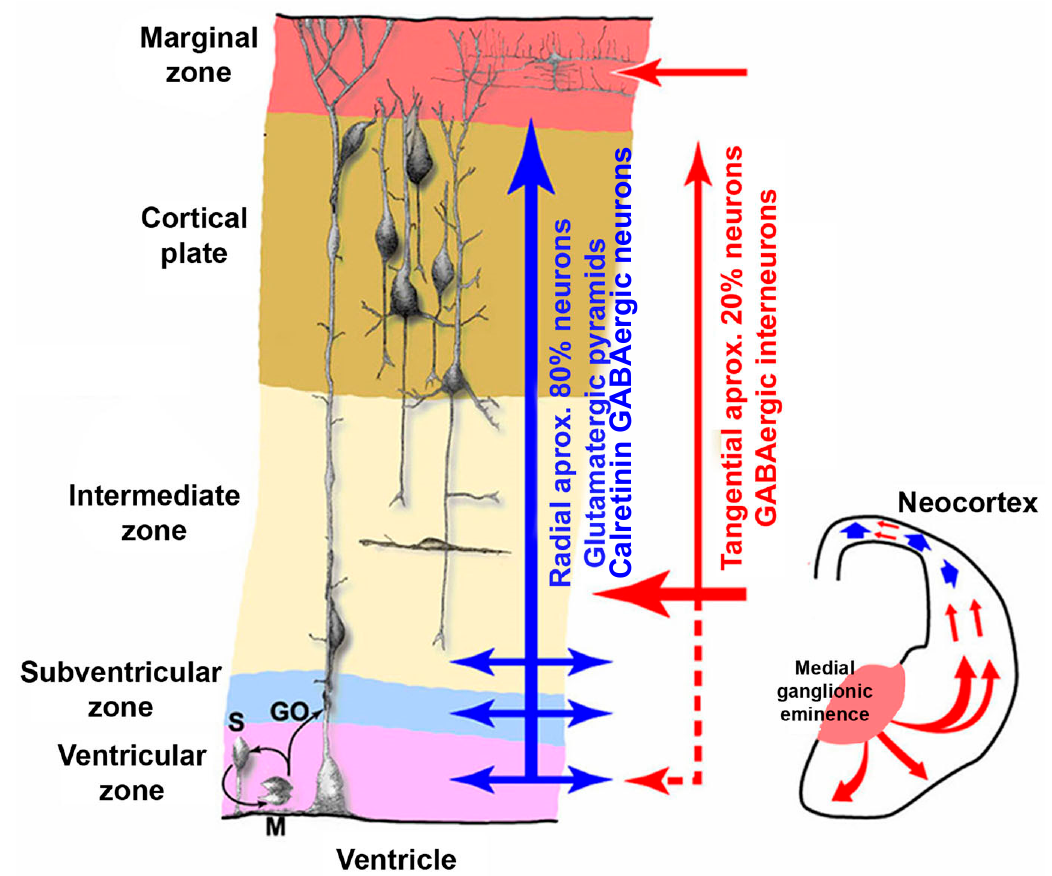
Figure 2. The neuronal migration process is affected by moderately low thyroid hormone levels in early foetal life. The figure shows a disorganized cortical plate where both the radial (blue arrow) and tangential (red arrow) migratory pathways are distorted by maternal hypothyroxinemia (courtesy of Berbel P).